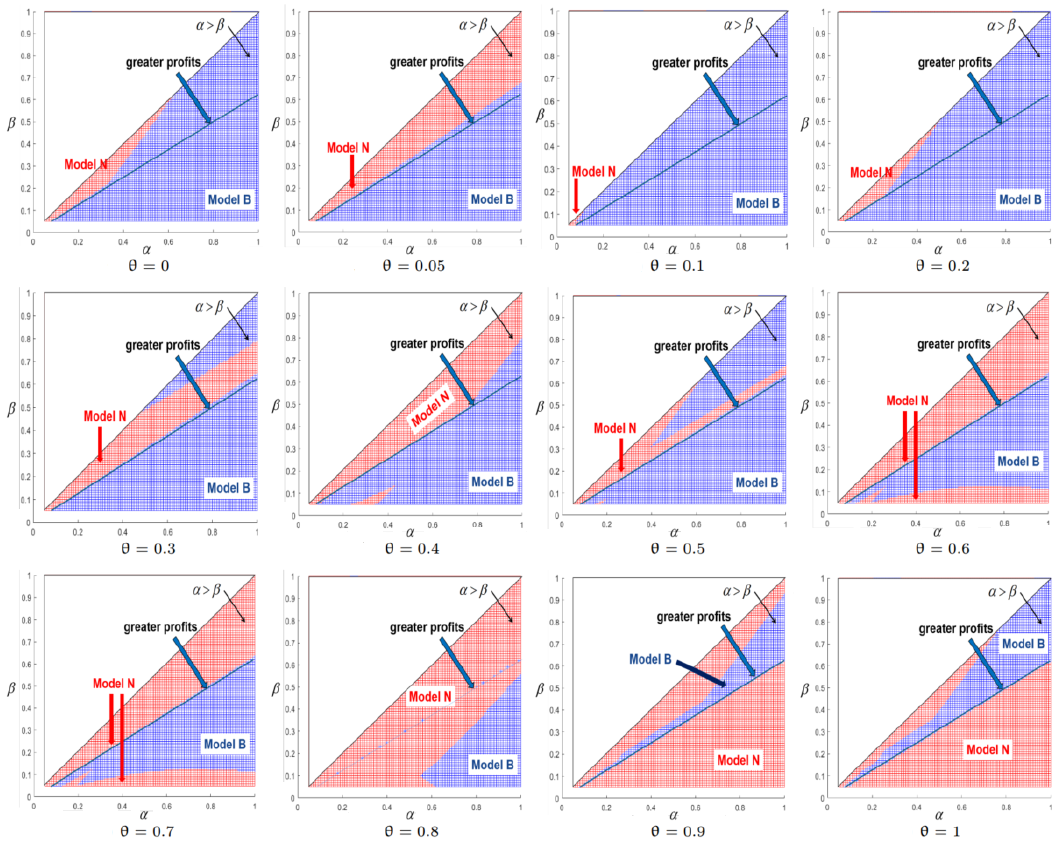
Figure 10. Bundling option of the ride-hailing platform with the combination of α and β .